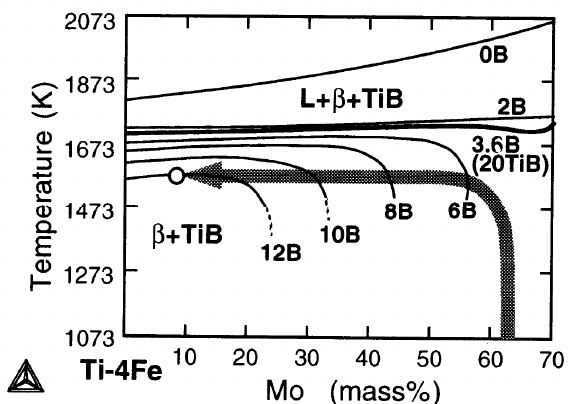
Figure 14. Effect of boron content on solidus line of Ti4Fe-Mo pseudo-binary system showing diffusion path of molybdenum during sintering (reprinted from Materials Science and Engineering: A, 243, T Saito, H Takamiya, T Furuta, Thermomechanical properties of P/M β titanium metal matrix composite, 6, Copyright (2022), with permission from Elsevier).